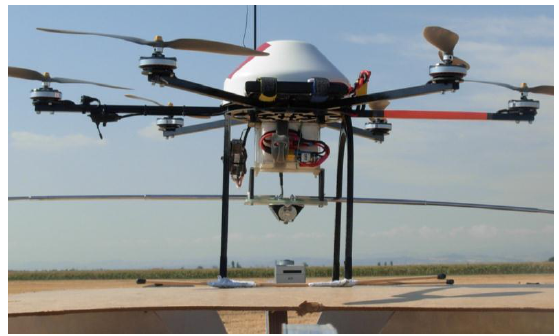
Figure 3 The Microkopter hexacopter modified by